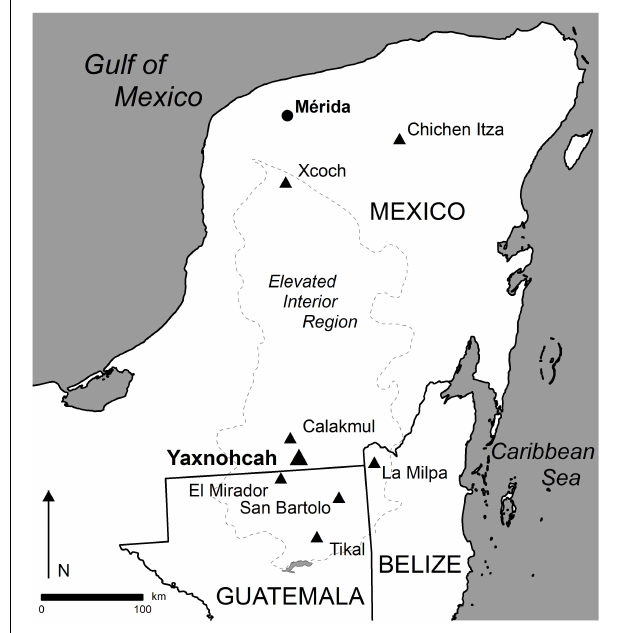
FIGURE 1 | Greater Maya area showing the location of Yaxnohcah and contemporaneous communities.